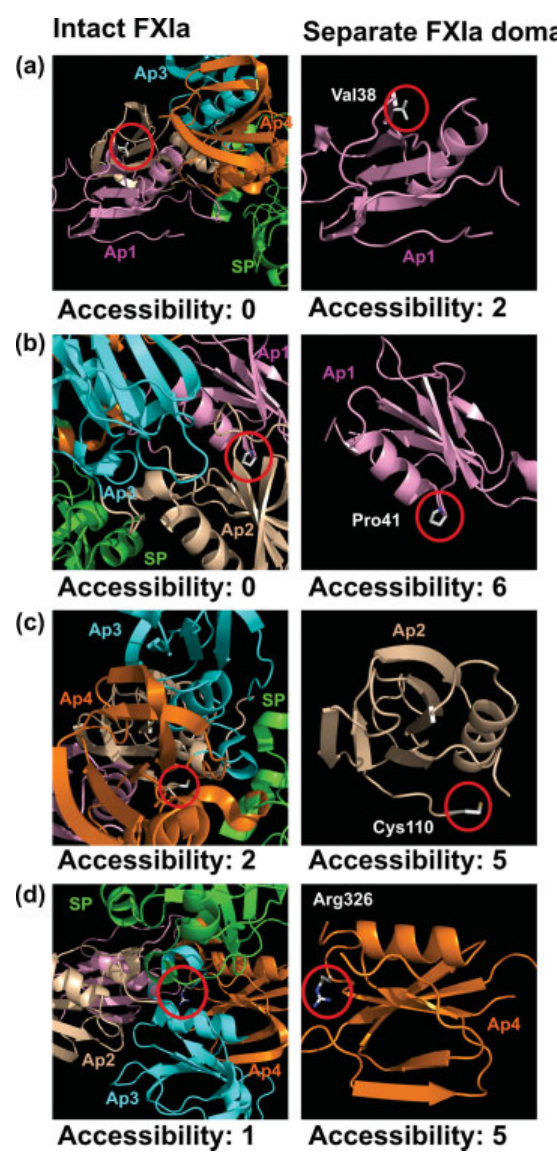
Fig. 9 Molecular graphic representation of residues within the FXI protein structure. The left-hand panel highlights the residue of interest and its calculated solvent accessibility in the native FXI protein. The right-hand side panel shows the same residue in its respective isolated domain, with its corresponding accessibility. Panels (a), (b), (c) and (d) highlight the residues Val38, Pro41, Cys110 and Arg326 respectively. Accessibility calculations are detailed in the Methods section. The domain coloring corresponds to that in ► Figure 3 . All residue numbering is given in HGVS